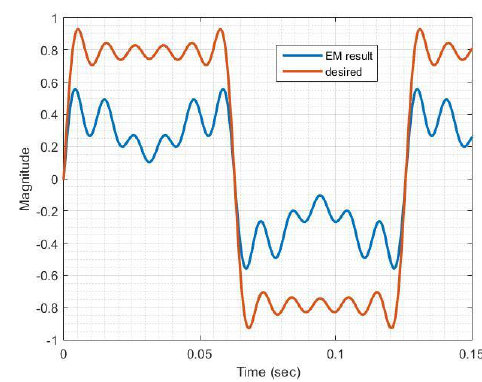
Figure A9. EM GMM Algorithm result; compositing of sinewaves (50, 150, 250, 350, 450, 550 Hz) [2,4].